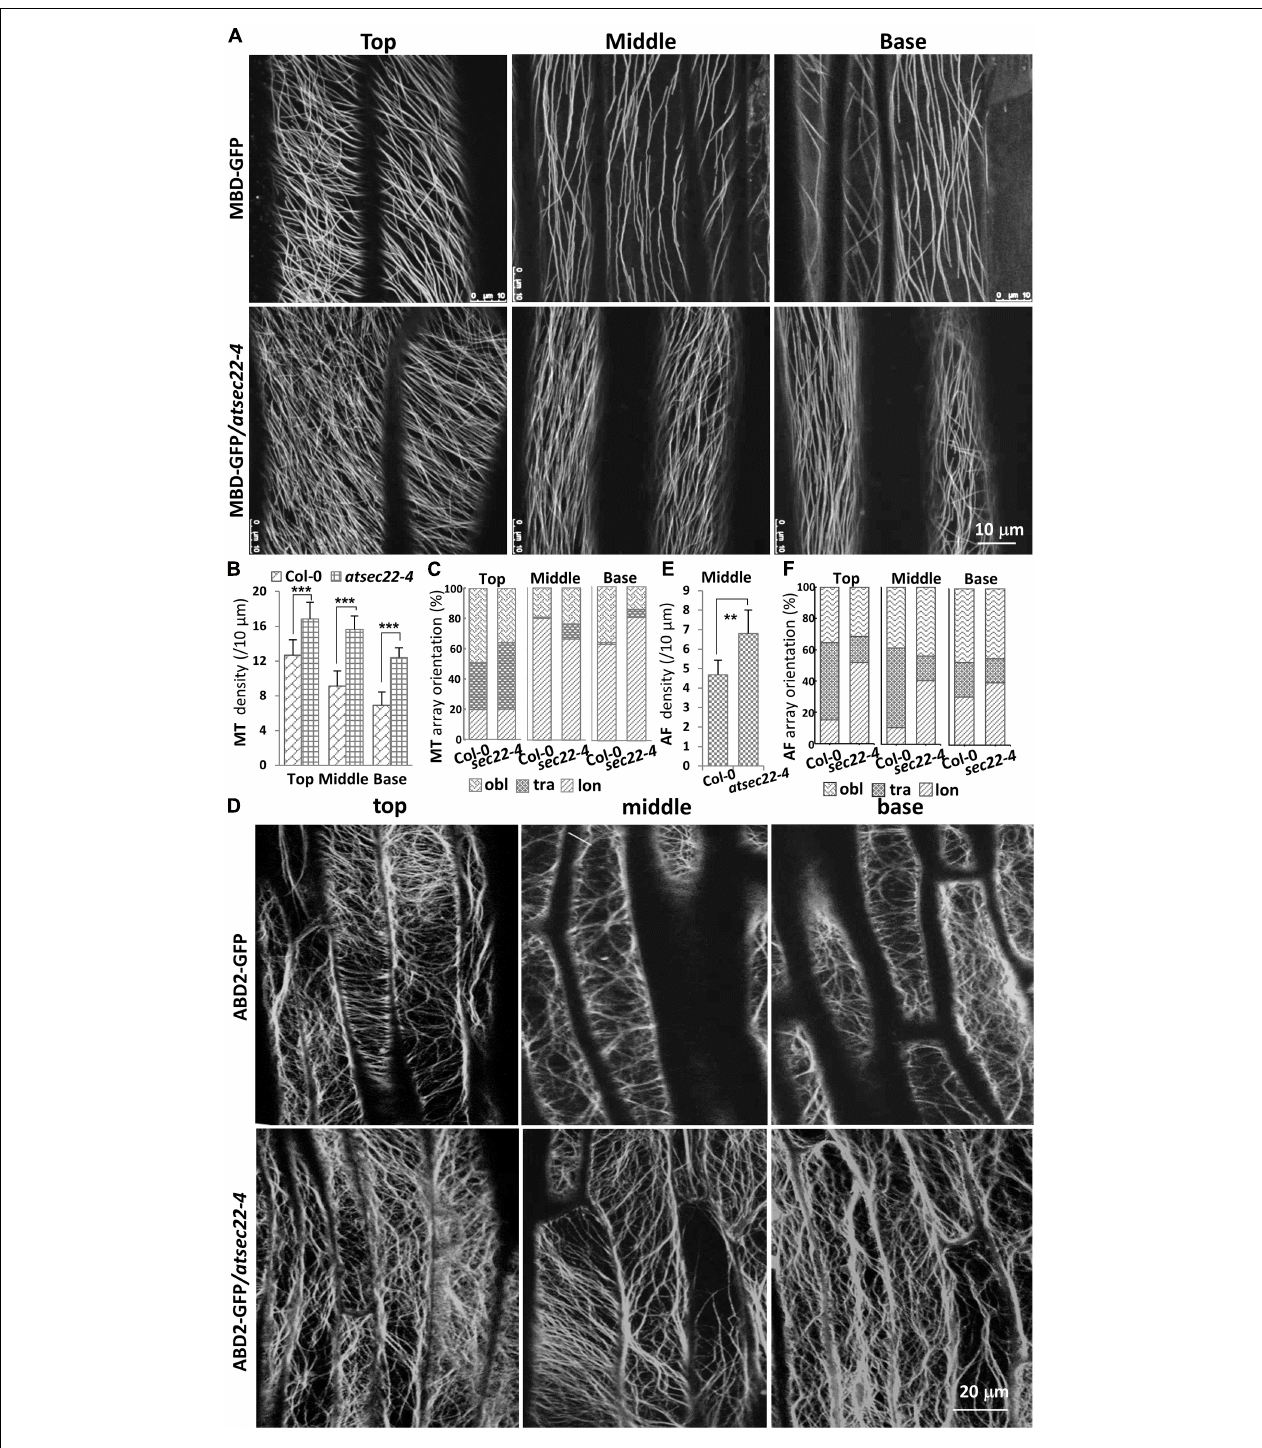
FIGURE 5 | Cytoskeleton organization was disturbed in atsec22-4. (A) Confocal images of MBD-GFP-visualized cortical MTs in the top, middle, and basal regions of hypocotyls from five-day-old seedlings grown in the dark. (B) Statistics of cortical MT density in panel (A) . (C) Statistics of cortical MT array orientations in (A). (D) Confocal images of ABD2-GFP-labeled AFs in the top, middle, and basal regions of hypocotyls. (E) Statistics of AF density in middle region of hypocotyls (D). (F) Statistics of AF array orientations in panel (D) . lon, longitudinal; tra, transverse; obl, oblique. n ≥ 10 cells. Scale bars are as shown. ** P < 0.01, *** P < 0.001. Significance was evaluated by Student’s t